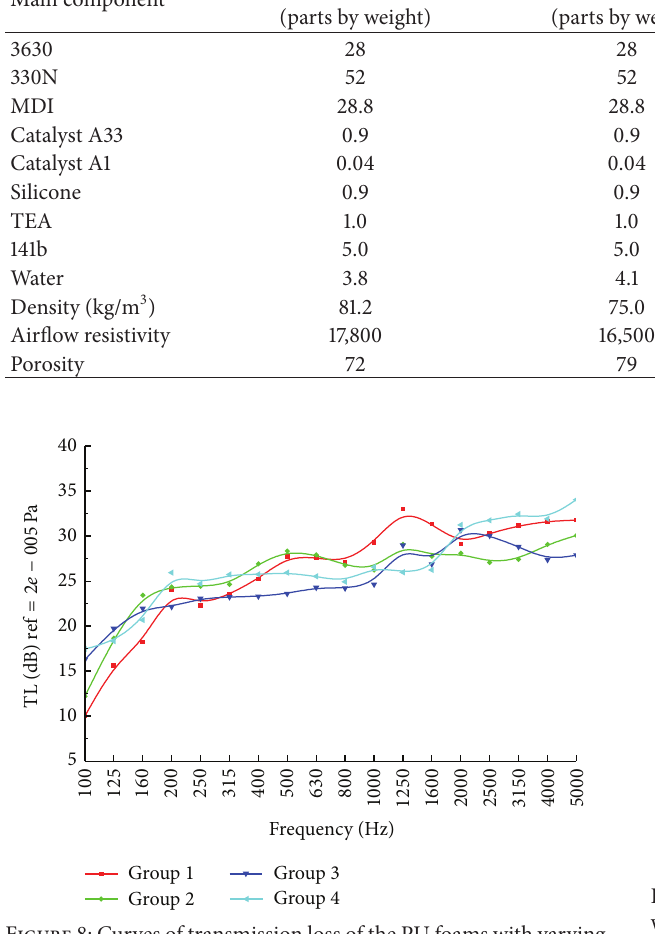
Figure 8: Curves of transmission loss of the PU foams with varying water contents. (a) Group 1 with water 3.8 parts by weight, (b) Group 2 with water 4.1 parts by weight (c) Group 3 with water 4.4 parts by weight, and (d) Group 4 with water 4.7 parts by weight.